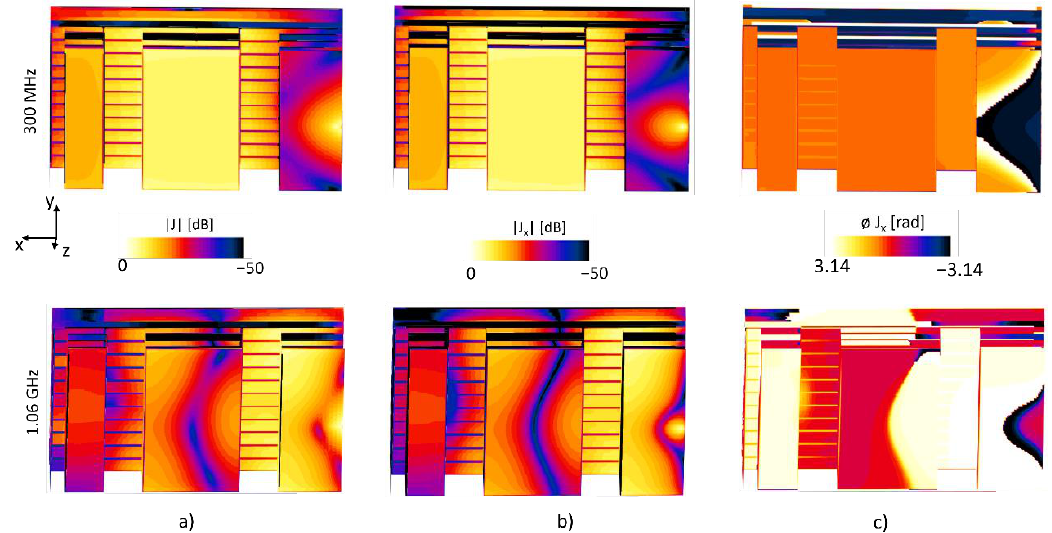
Figure 6. The current density distribution J of the proposed patch antenna. Showing in the top of the figure the 300 MHz and bottom the 1.06 GHz, for ( a ) the vector field of the current density, ( b ) the x component of current density, J x and ( c ) the phase of J x .